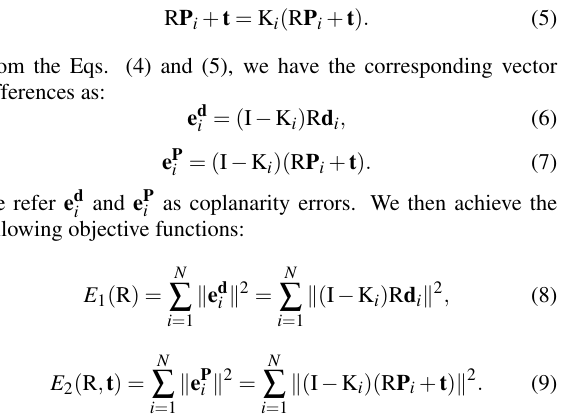
Figure 1: The geometry of the camera model